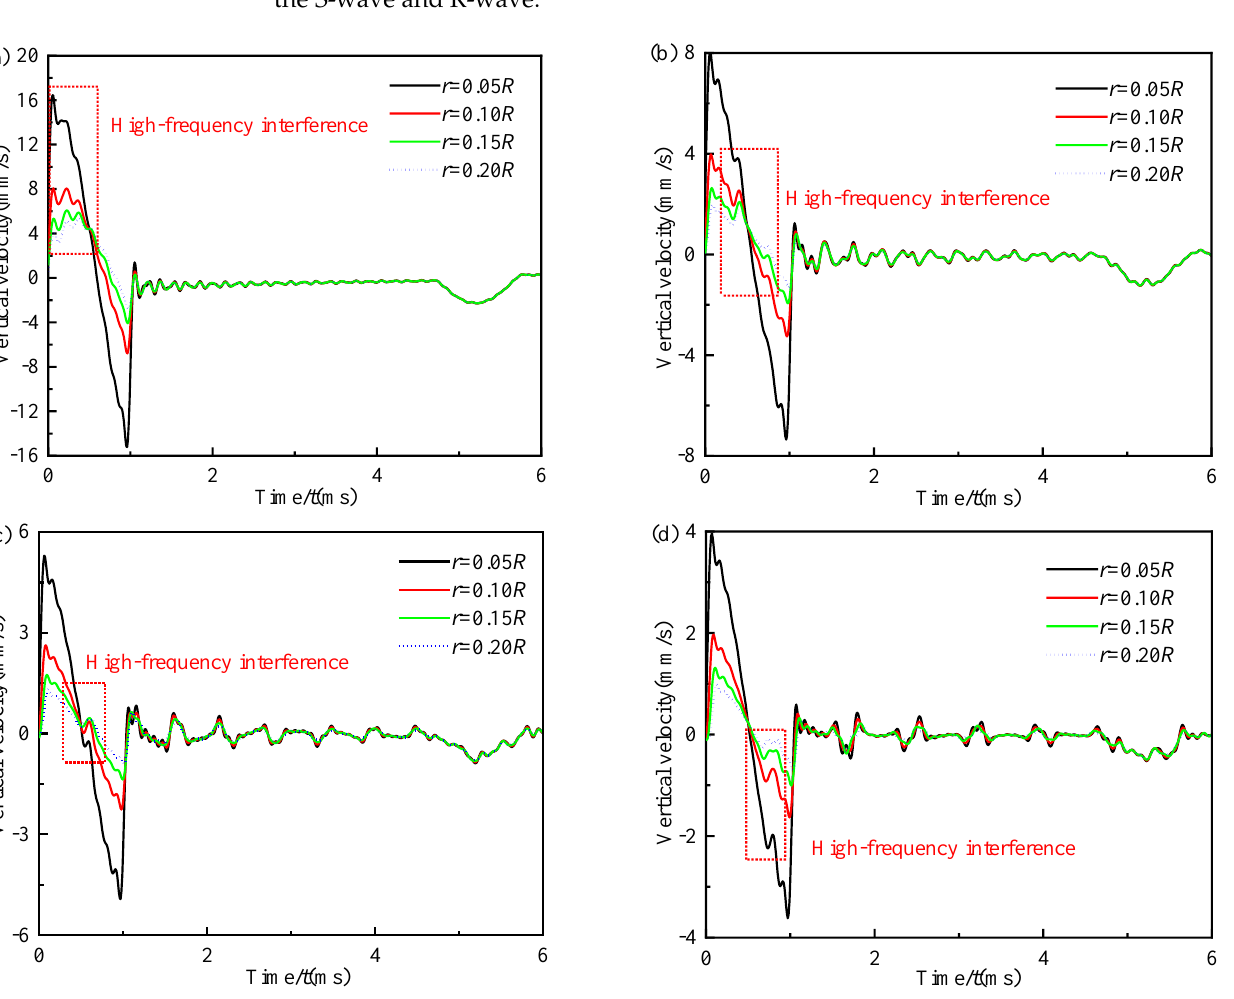
Figure 12. Vertical velocity time histories of different test points near the excitation region on the pile top: ( a ) R = 0.25 m; ( b ) R = 0.5 m; ( c ) R = 0.75 m; ( d ) R = 1.0 m.